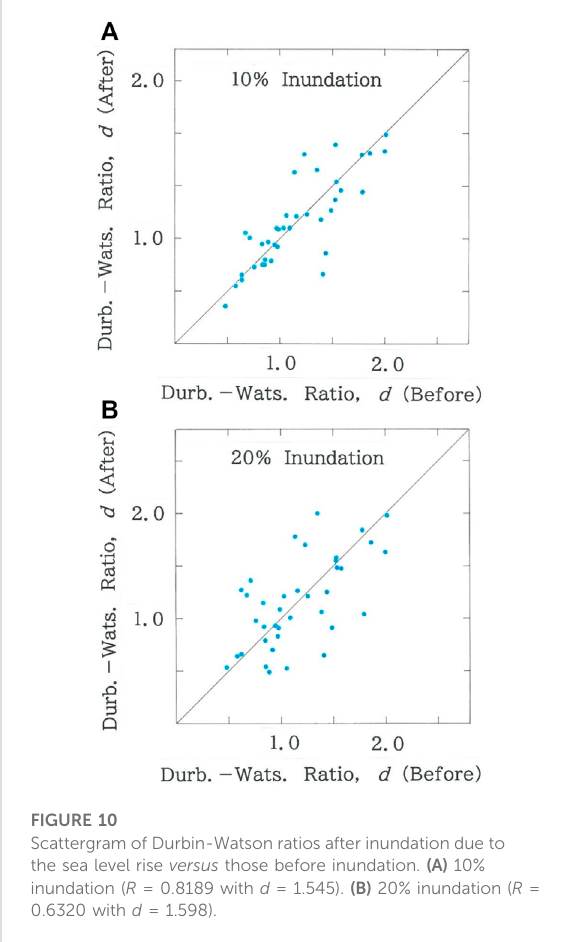
FIGURE 10 Scattergram of Durbin-Watson ratios after inundation due to the sea level rise versus those before inundation. (A) 10% inundation ( R = 0.8189 with d = 1.545). (B) 20% inundation ( R = 0.6320 with d = 1.598).